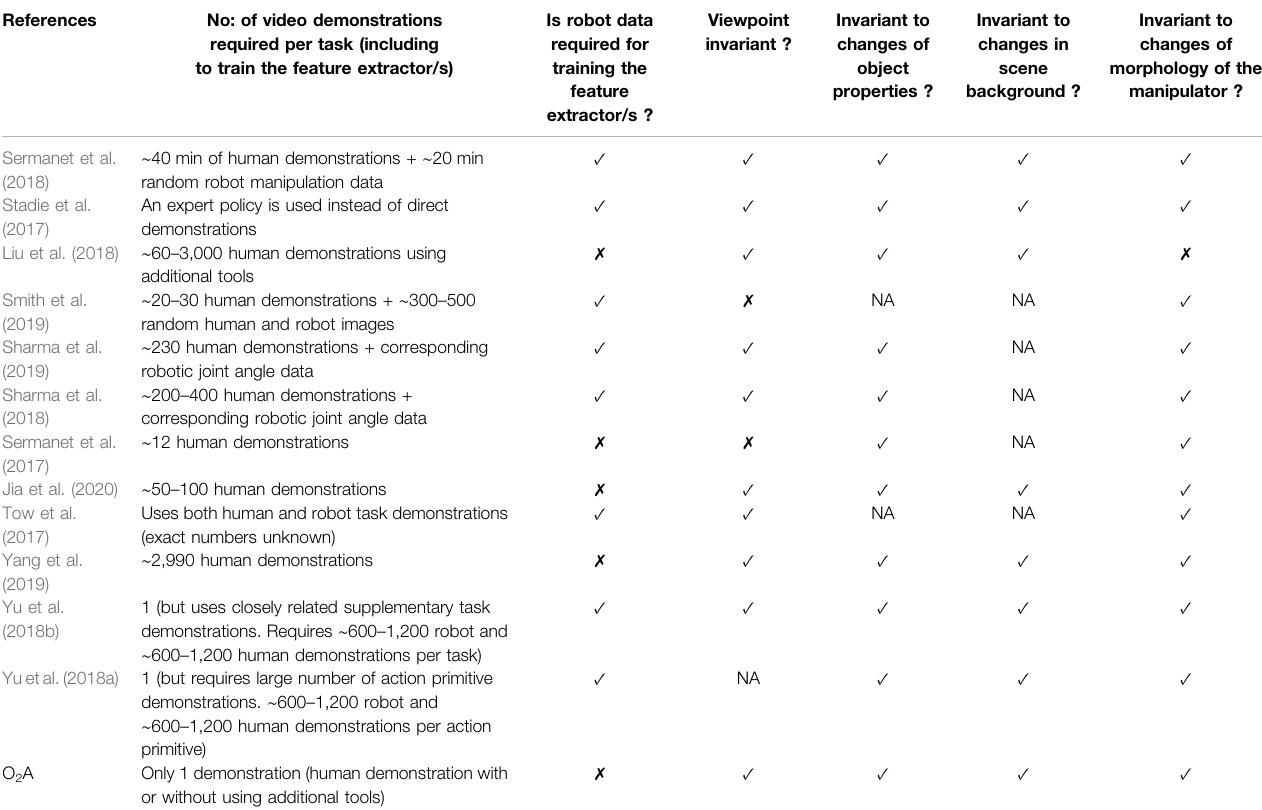
TABLE1| Observationallearningmethodsinexistingliteraturearecompared.O 2 Arequiresonlyasingledemonstrationtolearnnewtasks.Itdoesnotuseanyrobotdatafor training the action vector extractor and also works well under different domain shifts. No: of video demonstrations required per task (including to train the feature